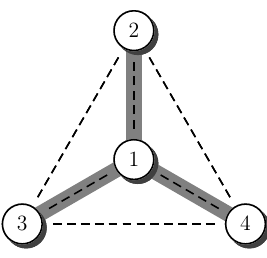
Figure 2. A star graph on K 4 , centered at 1. Figure 2: A star graph on K 4 , cen- tered at 1 .